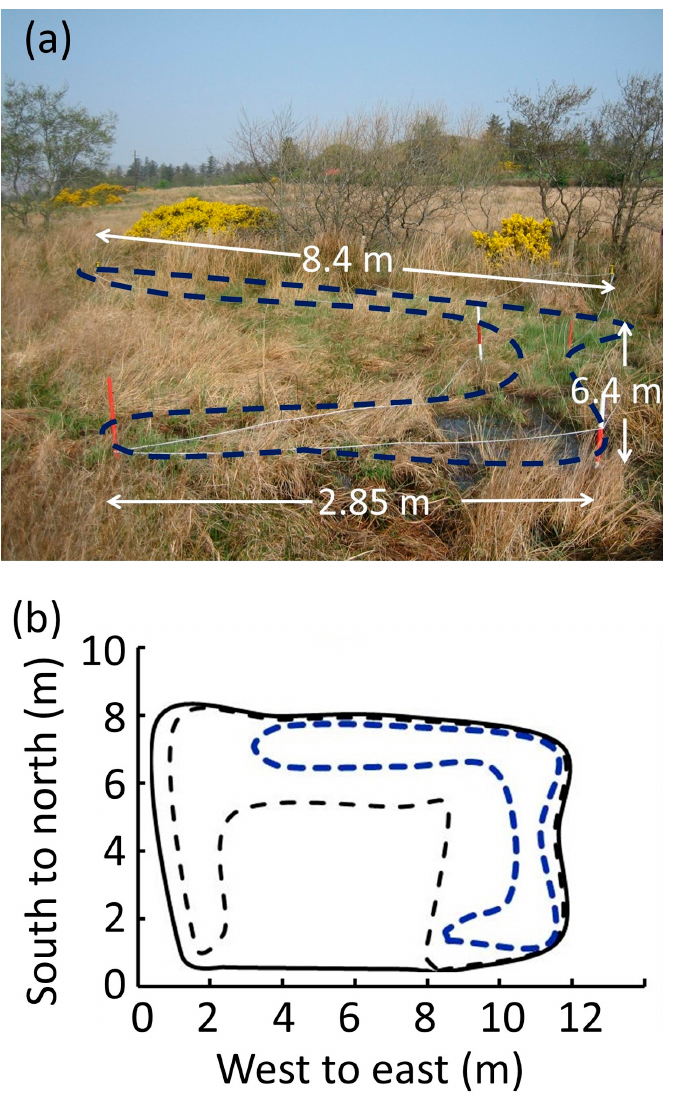
Figure A4. The location consistent with Fitzgerald’s “20-foot-square hole,” at which the ball of light first disappeared into the peat. ( a ) Photo of the “square hole” with dimensions and 0.5 m deep contour (dashed blue line). ( b ) Contours at three depths are shown: 0 m (solid black line), 0.3 m (dashed black line), and 0.5 m (dashed blue line). The natural feeder drainage flows approximately from the lower right to the upper left. Orientation to north is approximate.